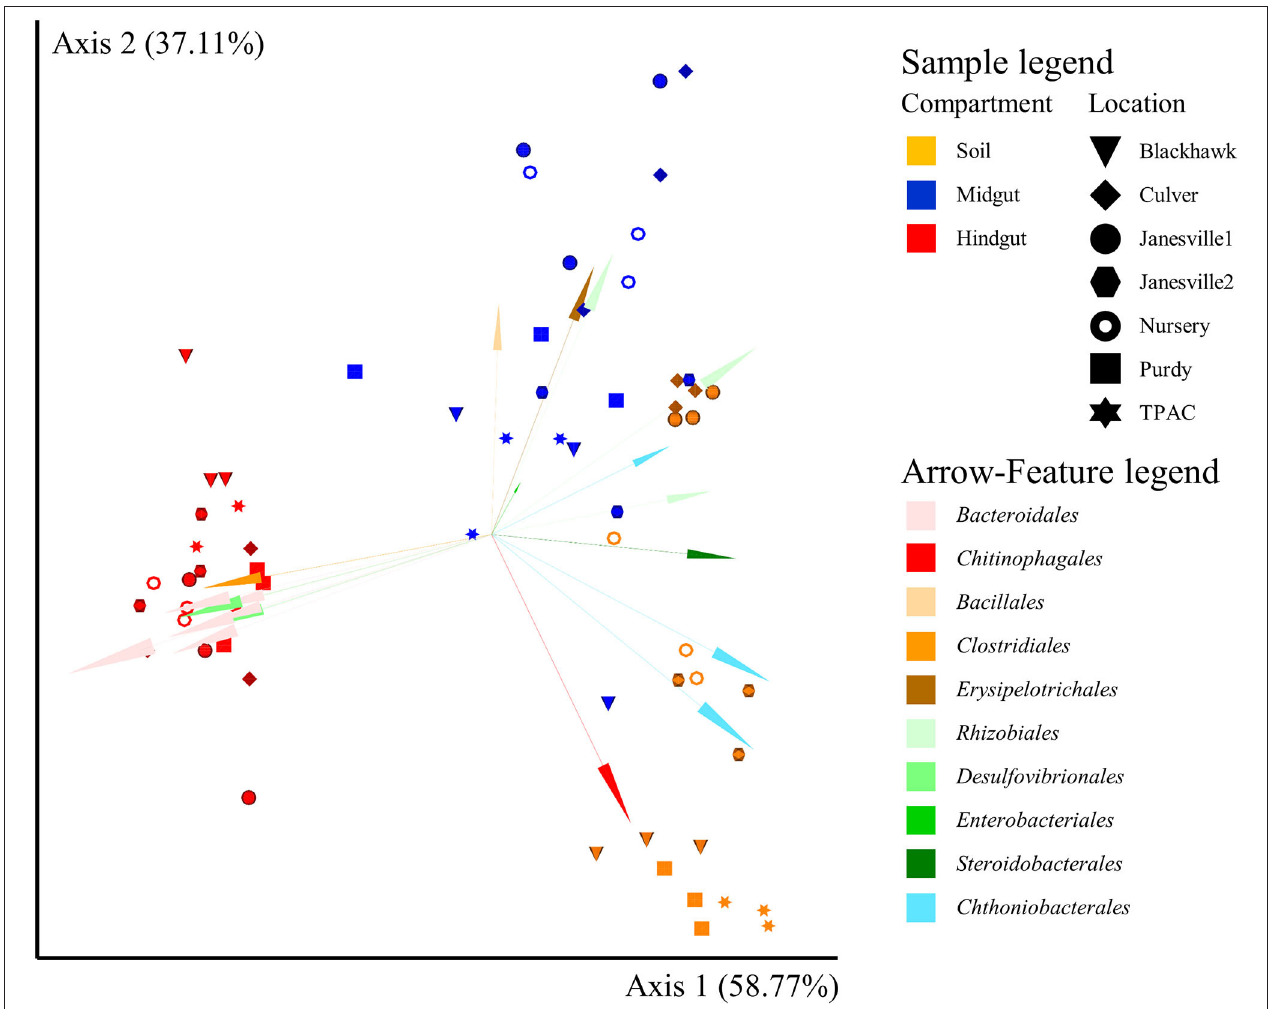
FIGURE 4 | Compositional principal coordinate analysis (PCoA) biplot portraying beta diversity of prokaryotic communities in midgut and hindgut of third instar Japanese beetle ( P. japonica ) larvae and associated soil. The PCoA biplot was generated using DEICODE (Robust Aitchison PCA) ( Martino et al., 2019) and visualized in Emperor ( Vázquez-Baeza et al., 2013). Data points represent individual samples where symbol shape denotes location while symbol color denotes compartment (i.e., midgut, hindgut, or soil). The top 20 taxa driving differences in ordination space at the order rank are illustrated by the arrows. All taxa belong to Bacteria . The phyla within Bacteria are represented by specific hues, where Bacteroidetes (7) = red/pink, Firmicutes (3) = orange/brown, Proteobacteria (7) = green, and Verrucomicrobia (3) = blue. SILVA v132 database (Quast et al., 2012; Glöckner et al., 2017) was used for taxonomic